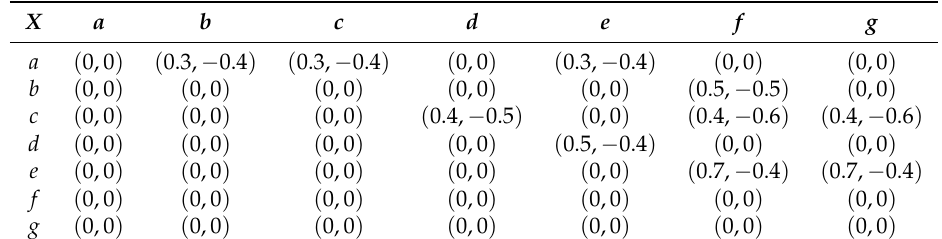
Table 1: Adjacency Matrix X